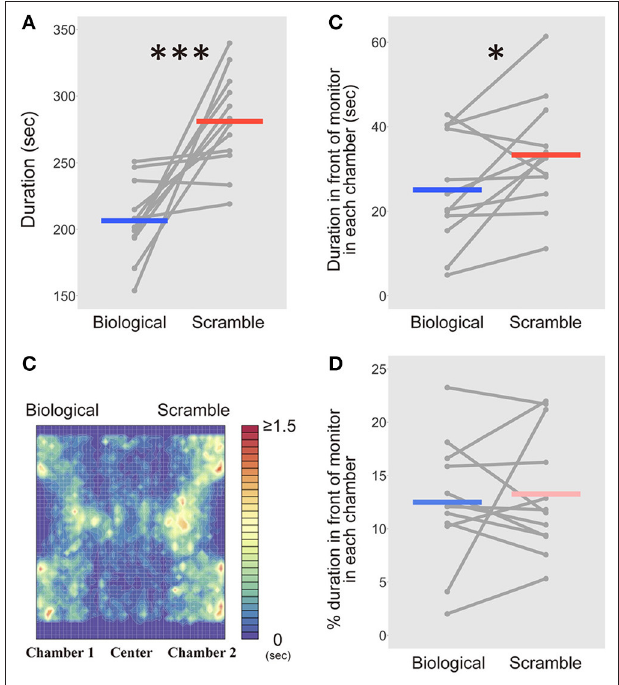
FIGURE 4 | Results of the time spent in the chambers with each movie stimulus condition in the Movie test over 2 days ( N = 12). (A) The difference between Biological and Scramble movies was significant (*** p < 0.001). (B) A heat map of activity in the three-chambered apparatus during the test phases was estimated by averaging the occupancy times across the days for each mouse. (C) The time spent in front of the monitors. The difference between Biological and Scramble movies was significant (* p < 0.05). (D) Percentage of duration spent in front of the monitors during the entire time in each chamber. Gray dots and lines indicate the individual data, and horizontal colored bars show the averaged time in each condition, respectively.